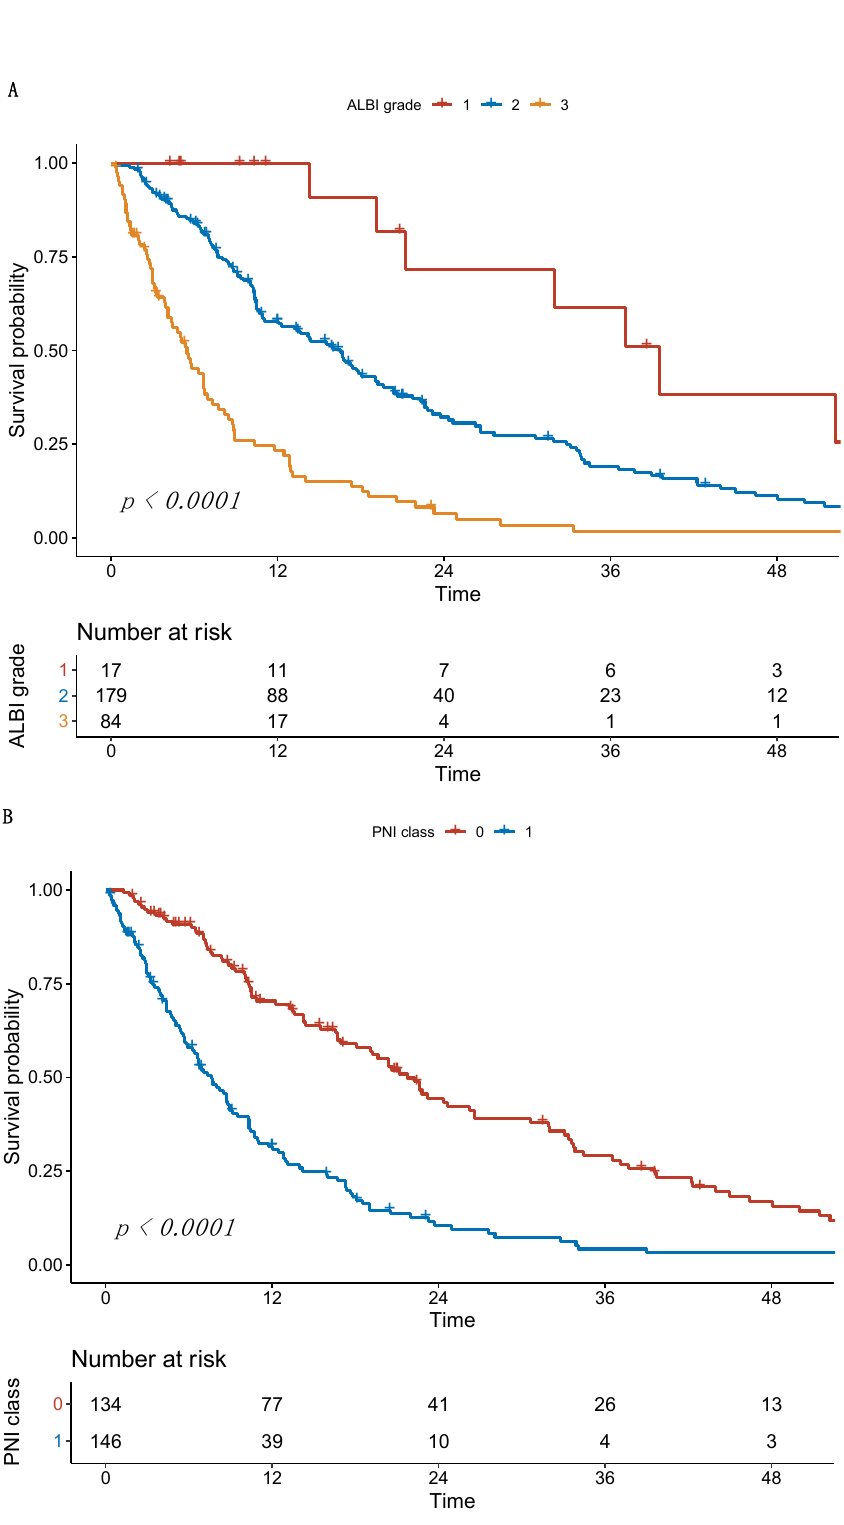
Table 2. Univariate and multivariate Cox proportional hazards regression models evaluating PNI, ALBI grade, and other risk factors.